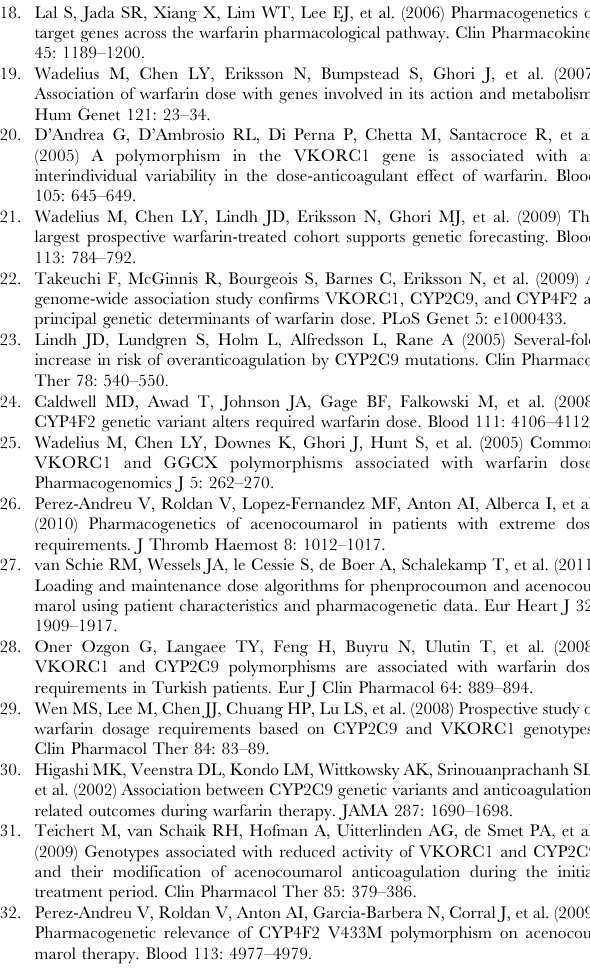
algorithm. Comparison of the mean absolute error (MAE) of each algorithm was used to evaluate the performance of each